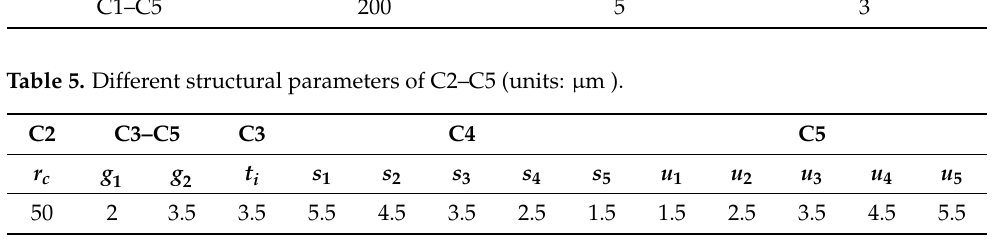
Table 4. Common structural parameters of C1–C5.